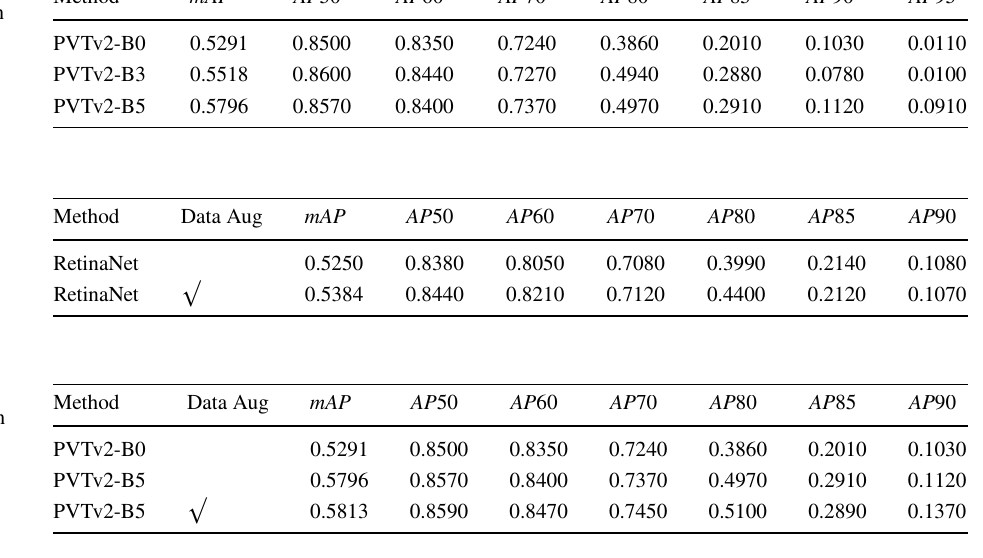
Table 4 Ablation experiments of the depth effect of PVTv2 on HRSC2016